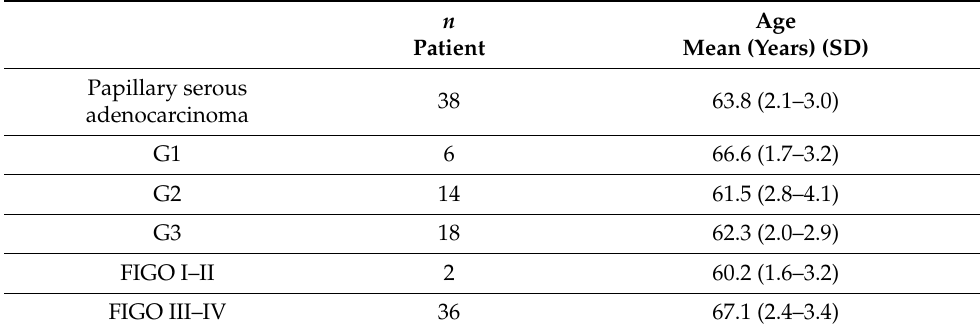
Table 2. Descriptive characteristics of patients with ovarian